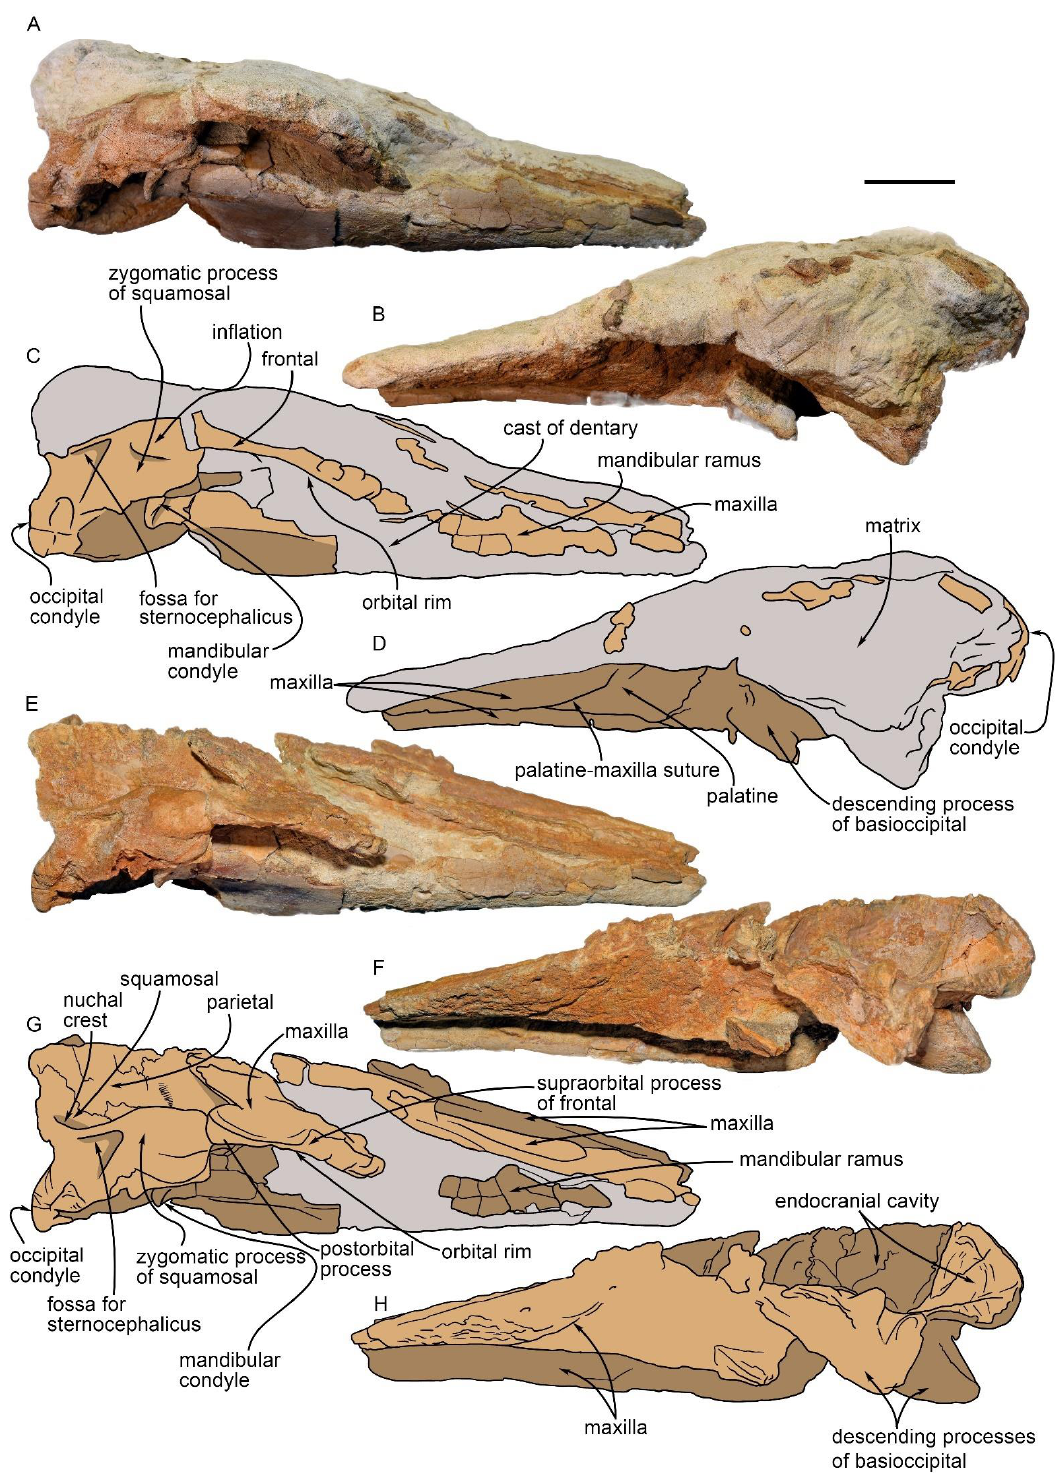
Figure 5. The partial skull MGPT-PU 13881/1 in lateral view. ( A ) Photographic representation of the skull before preparation in right lateral view. ( B ) Photographic representation of the skull before preparation in left lateral view. ( C ) Anatomical interpretation of ( A ). ( D ) Anatomical interpretation of ( C ). ( E ) Photographic representation of the skull after preparation in right lateral view. ( F ) Anatomical interpretation of ( E ). ( G ) Photographic representation of the skull after preparation in left lateral view. ( H ) Anatomical interpretation of ( G ). Scale bar equals 5 cm.